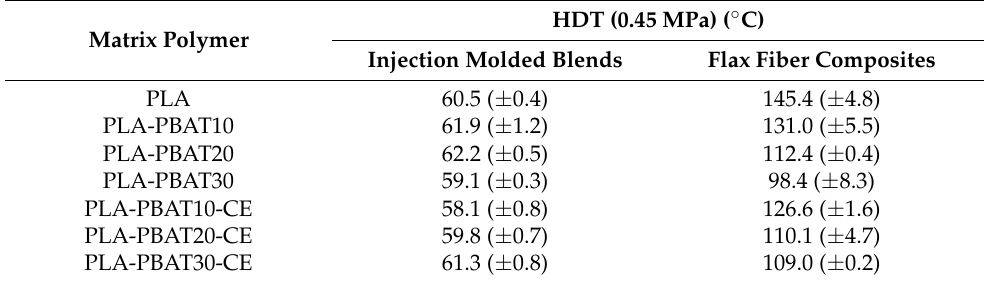
Table 3. Results of the heat deflection temperature (HDT) measurements Matrix